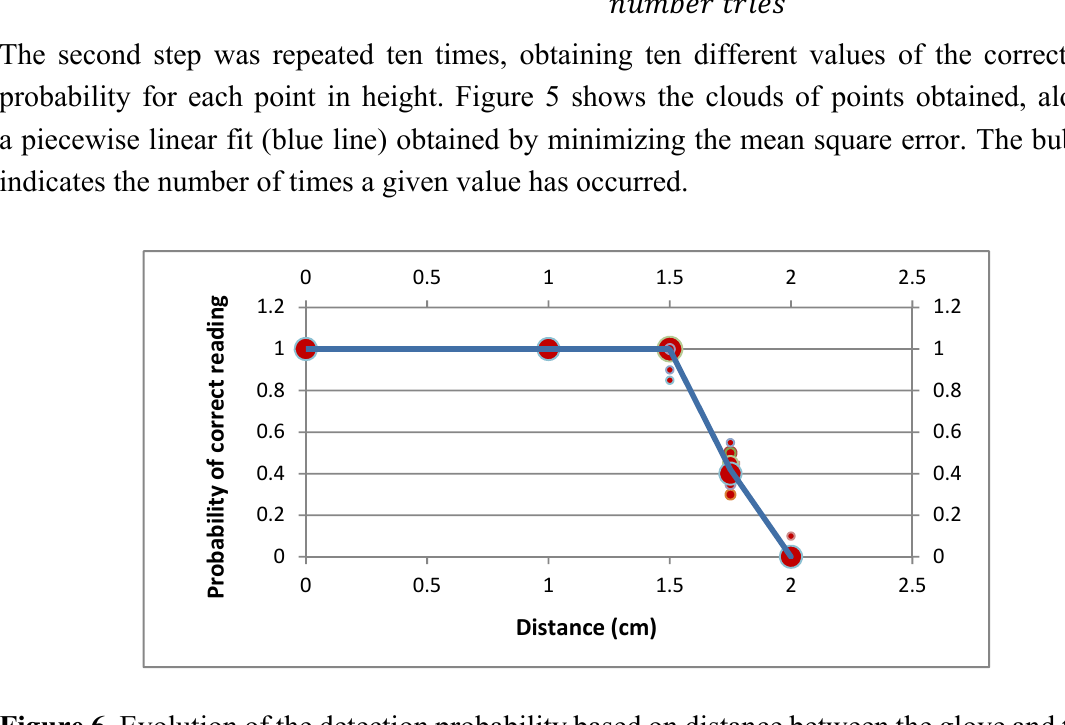
Figure 6. Evolution of the detection probability based on distance between the glove and the tagged